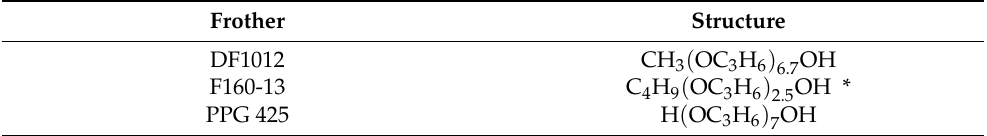
Table 2. Summary of critical coalescence concentrations for frothers tested, from Zhang, et al. [16].